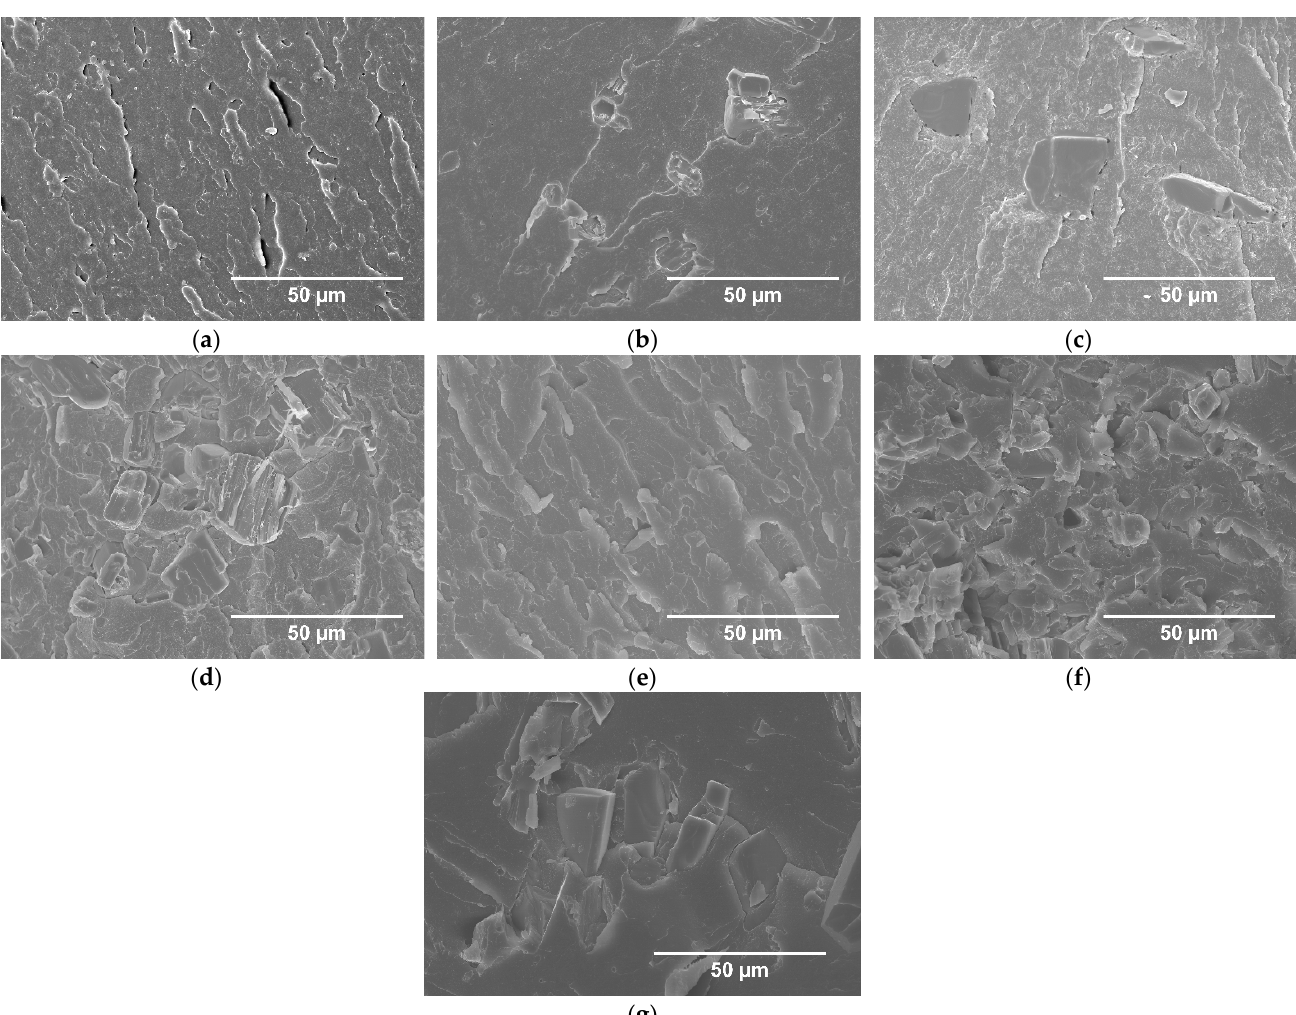
4 of 19 Table 1. Elemental analysis of LHP. Samples